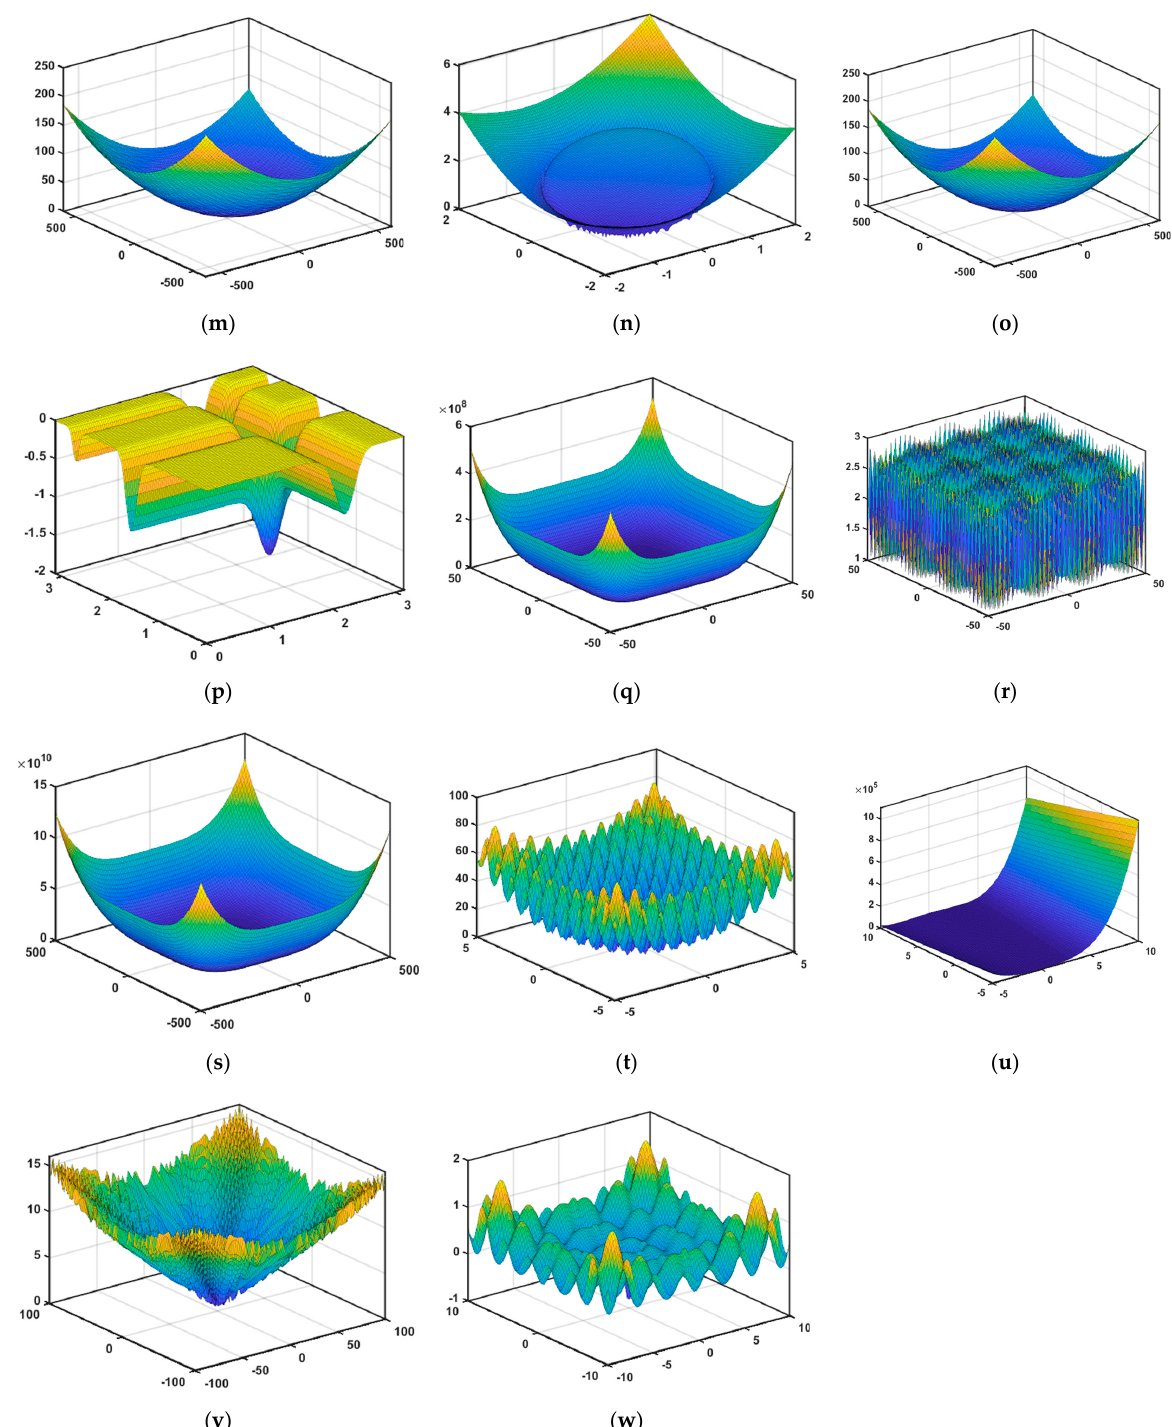
Figure 5. The landscape of the mathematical test functions: ( a ) The landscape of F1; ( b ) The landscape of F2; ( c ) The landscape of F3; ( d ) The landscape of F4; ( e ) The landscape of F5; ( f ) The landscape of F6; ( g ) The landscape of F7; ( h ) The landscape of F8; ( i ) The landscape of F9; ( j ) The landscape of F10; ( k ) The landscape of F11; ( l ) The landscape of F12; ( m ) The landscape of F13; ( n ) The landscape of F14; ( o ) The landscape of F15; ( p ) The landscape of F16; ( q ) The landscape of F17; ( r ) The landscape of F18; ( s ) The landscape of F19; ( t ) The landscape of F20; ( u ) The landscape of F21; ( v ) The landscape of F22; ( w ) The landscape of